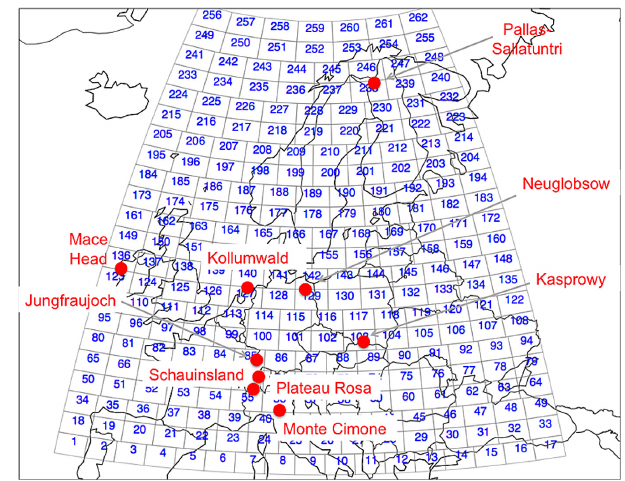
Fig. 1. The 262 tiles used in this study are 1.5 ◦ in latitude, and 1.5 to 7 ◦ in longitude, from south to north, in order to obtain a constant area of approximately 7000km 2